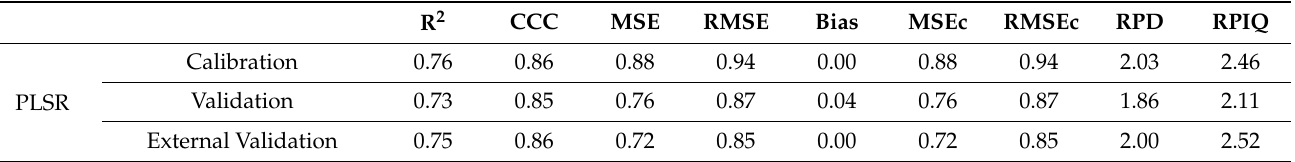
Figure 5. Measured versus predicted soil organic matter (%) using four different models (PLSR, Cubist, RF and ELM) for the ( a ) calibration dataset, ( b ) internal validation dataset, and ( c ) external validation dataset. Table 7. Model performance indicators of SOM prediction calculated in finalizing the right combination of preprocessing and modelling algorithms for all other soil